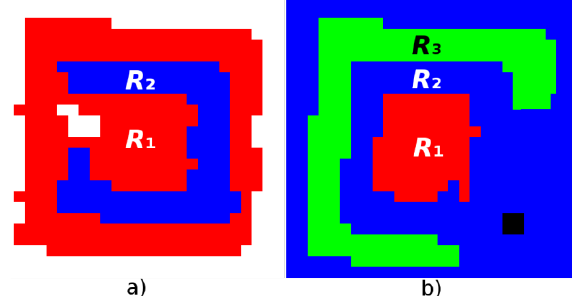
Figure 8. Various damages of Finder Patterns: ( a ) merged inner and outer black regions; ( b ) interrupted outer black region.